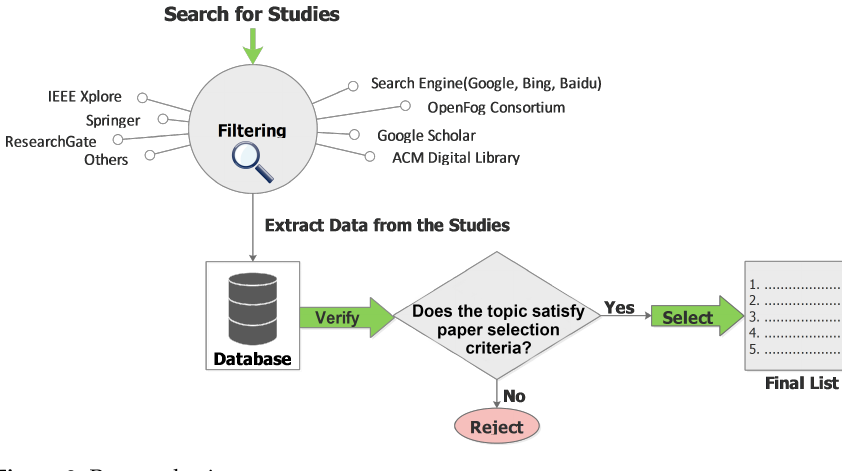
Figure 2. Paper selection